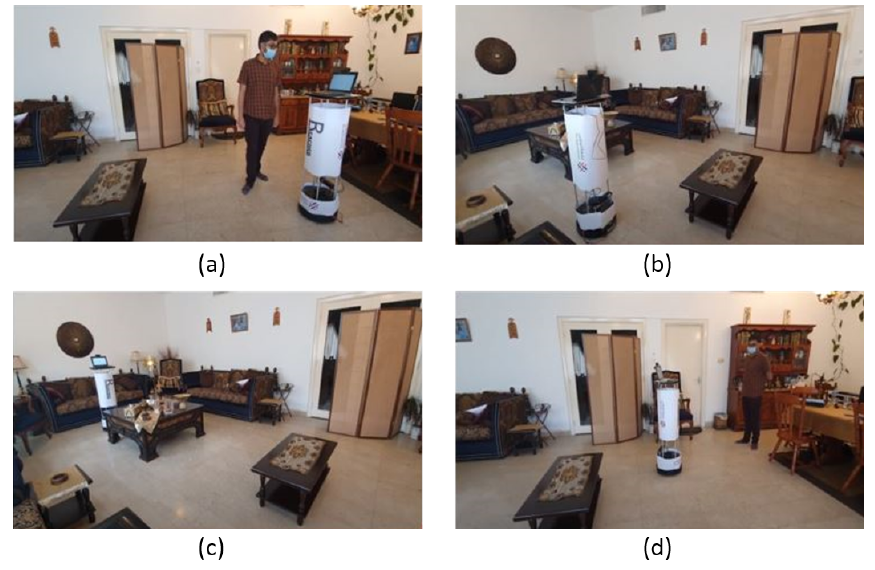
Figure 15. Robot navigating around a room with predefined goal points. ( a ) Shows the initial position of the robot, ( b ) illustrates the robot reaching the first goal point, ( c ) shows the robot when it arrived at the second goal point, and ( d ) depicts the robot after it arrived at the final goal